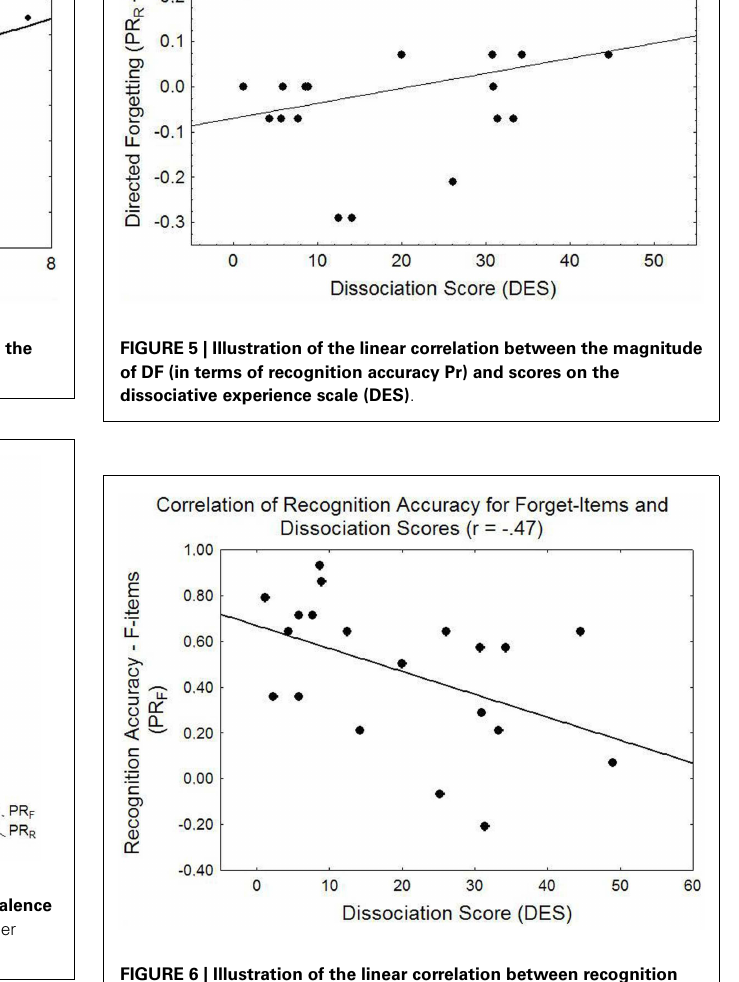
FIGURE 6 | Illustration of the linear correlation between recognition accuracy for to-be-forgotten items and dissociation scores